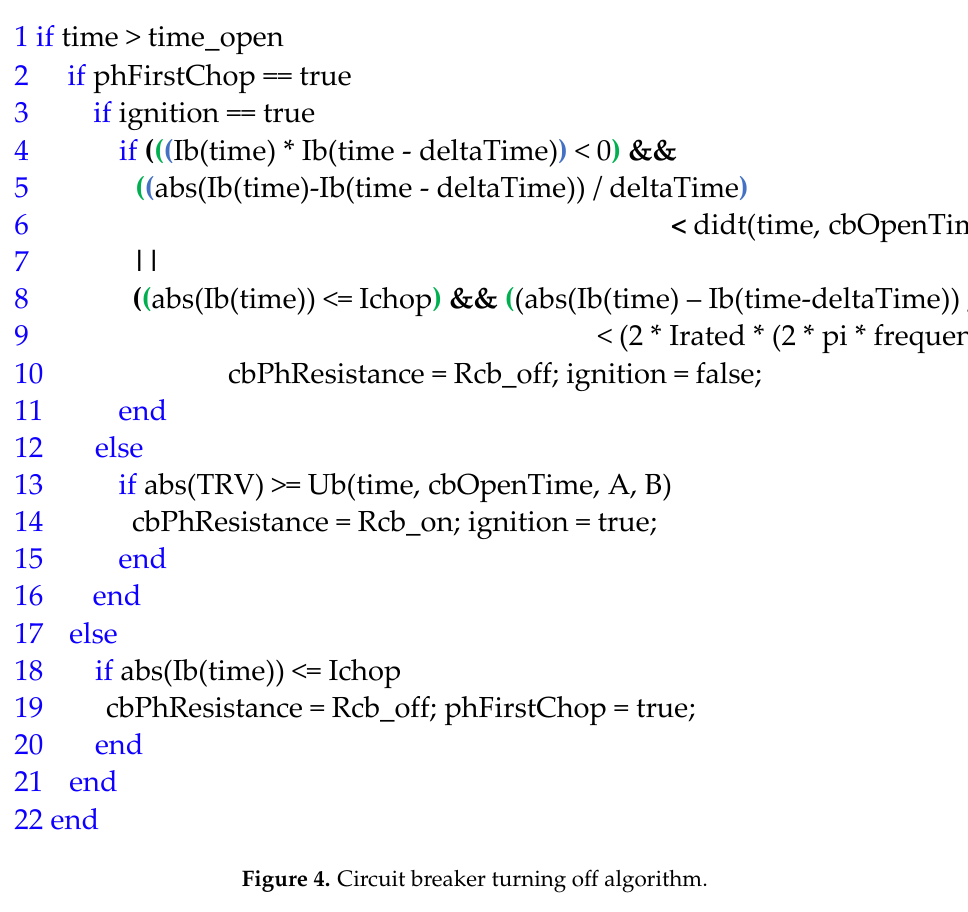
Figure 4. Circuit breaker turning off algorithm .